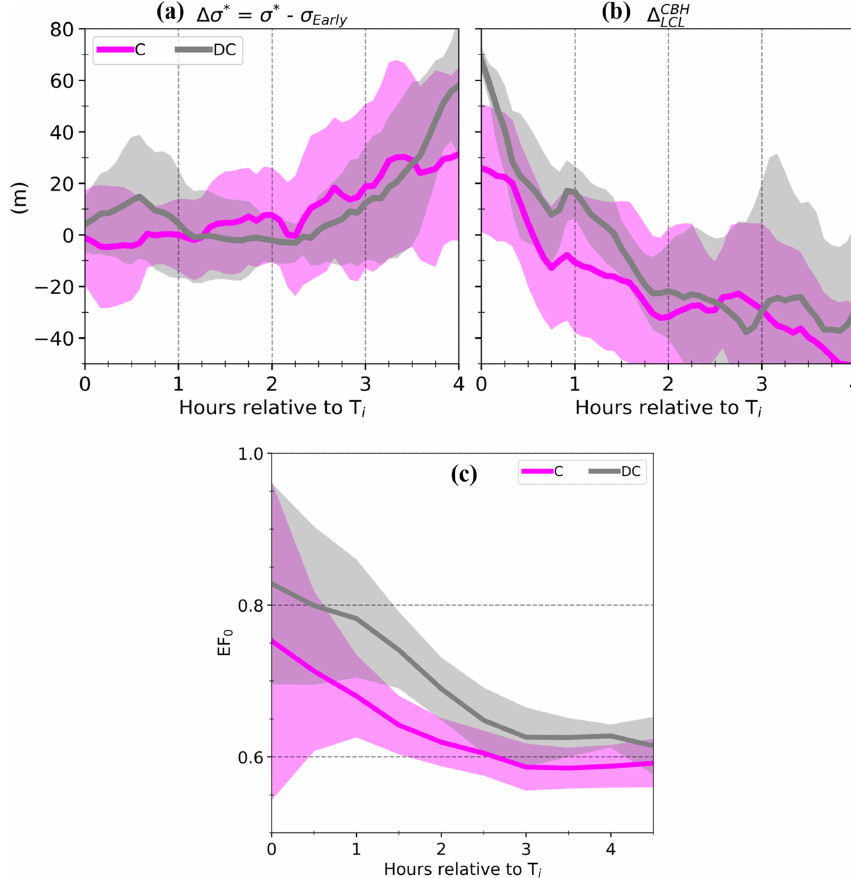
Figure 12. Evolution of (a) (cid:49)σ ∗ , which is the difference between the diagnostic parameter σ ∗ and its median over the period from 04:00 to 06:30UTC on day- D + 1 ( σ Early ), (b) the mean distance between the LLSC base height and surface-based LCL ( (cid:49) CBH evaporative fraction at the surface (EF 0 ) for C (coupled) and DC (decoupled-coupled) scenarios. The solid lines indicate the median and shaded areas represent the standard deviation. The time is expressed in hours relative to surface-convection influence time ( T i